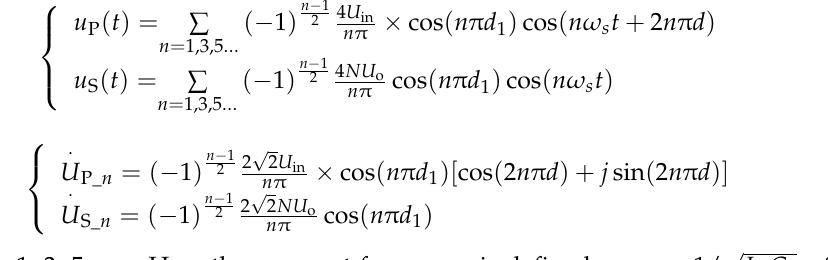
where T is the period of f ( x ) and ω = 2 π / T . Since the voltages and currents of the LCL resonant tank are periodic signals, the Fourier series expressions of them can be derived to (5) by substituting (1) and (2) into (4), respectively. Then, the phasor expression at each frequency can be expressed as (6).